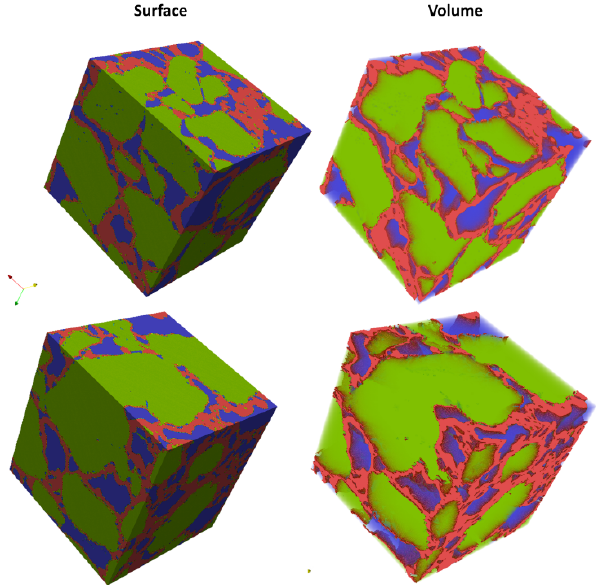
Figure 8. Segmented REVs of a gas hydrate sample displayed as surface, and volume rendered and analysed using CobWeb 1.0 and exported to .vtk format using the CobWeb 1.0 ParaView plugin. The quartz grain phase is represented in green colour, gas hydrate is in red, and in blue is the void